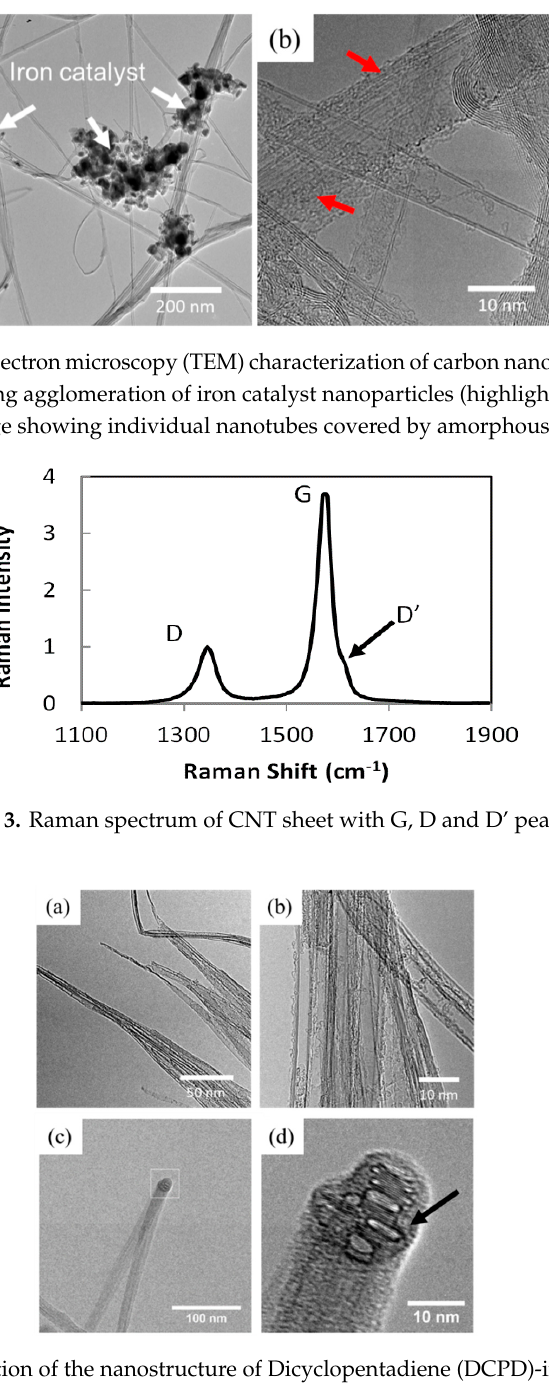
Figure 1. Carbon nanotube sheets before ( a ) and after ( b ) elongation to 30% strain.